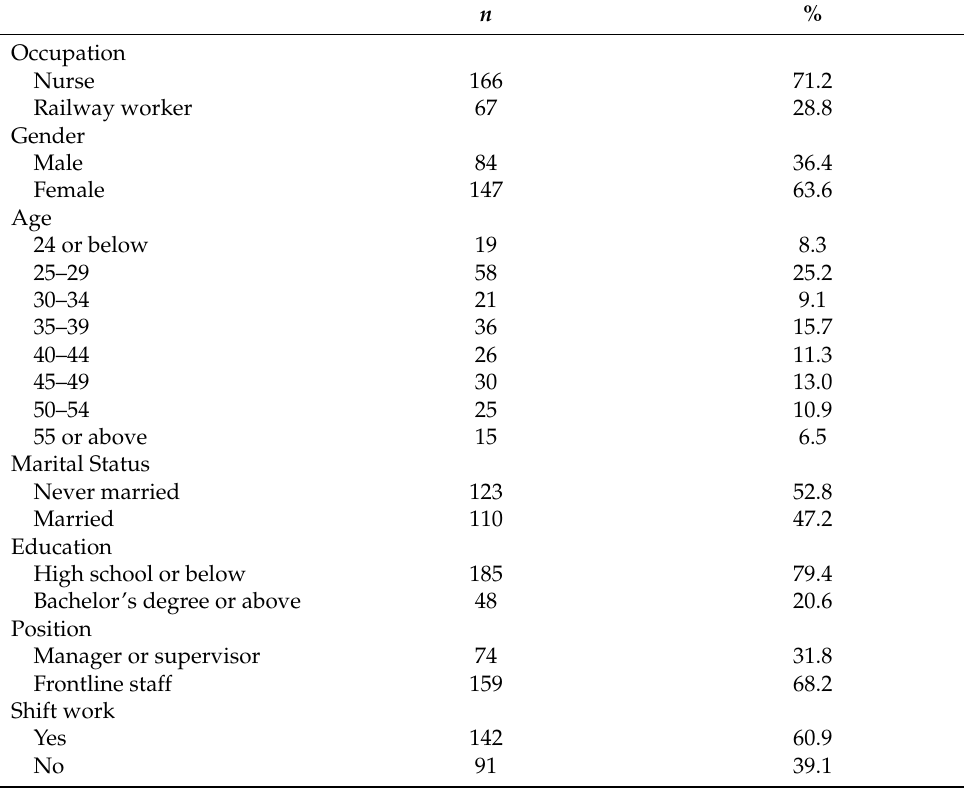
Table 1. Demographic characteristics of the